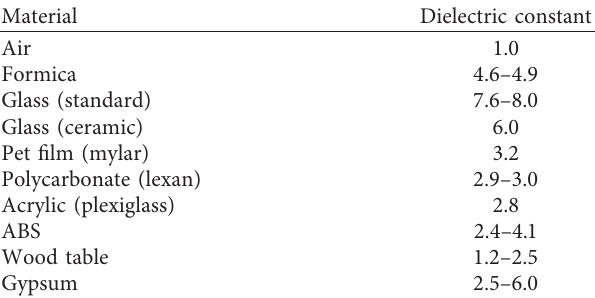
Table 1: Dielectric constants of insulation